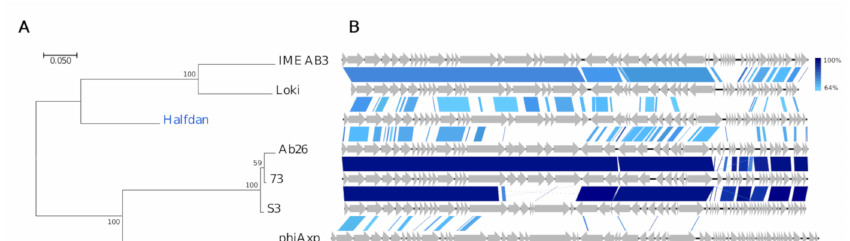
Figure 7. Comparisons of the new phage lineage representative Halfdan (blue text) and closest relatives (black text). ( A ) Phylogenetic tree, Maximum log Likelihood: − 7678.71, bootstrap 100, large terminase subunit TerL , scalebar: substitutions per site. ( B ) Pairwise alignment of phage genomes; color bars between genomes indicate percent pairwise similarity (Easyfig, BlASTn). Genomes have been modified to have similar starting